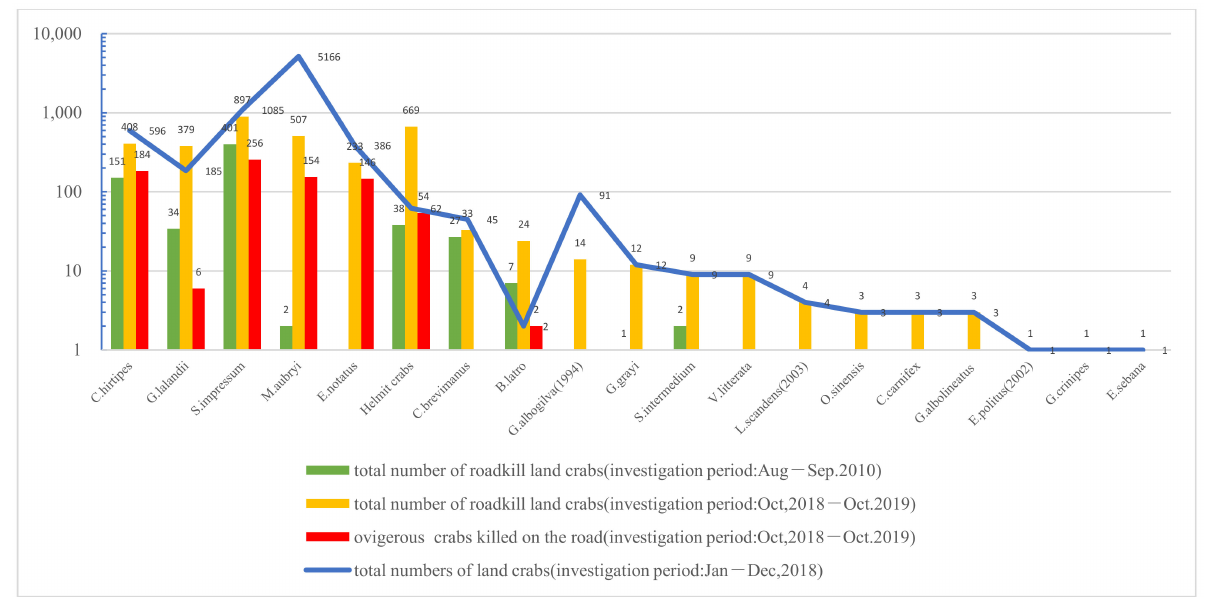
Figure 6. Comparison of land crab road kills in 2010 and 2019 (Note: data from [51,52]). According to the traffic flow survey on 26 August 2019, 7:45–8:45 p.m., there